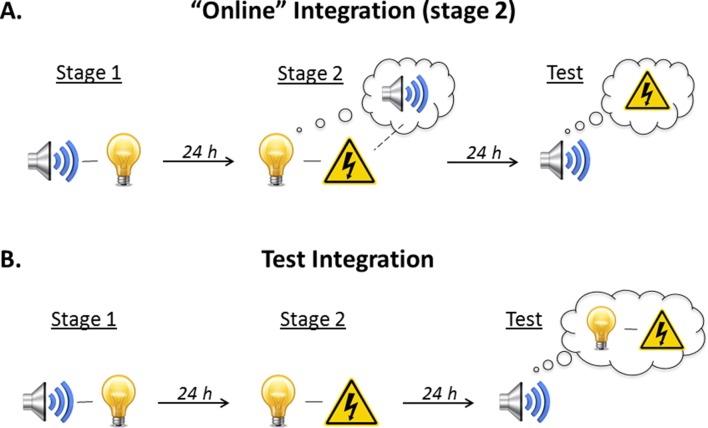
Illustration of the two possible mechanisms underlying integration of the sound-light memory formed in stage 1 and the light-shock memory formed in stage 2.(A) The first possibility is that the memories are integrated ‘online’ during training. When the subject is exposed to light-shock pairings in stage 2, presentation of the light triggers retrieval of its past associate, the sound, thereby allowing it to enter into an association with the shock. Test presentations of the sound then retrieve this mediated sound-shock association, and thus, elicit fear. (B) The second possibility is that the memories are integrated at the time of testing (‘memory chaining’). According to this account, the sound-light memory (stage 1) and the light-shock memory (stage 2) are formed independently of each other. It is at the point of testing, when the sound is once again encountered, that the subject retrieves the initial sound-light memory and integrates (or chains) it with the light-shock memory; thus, the sound elicits fear.